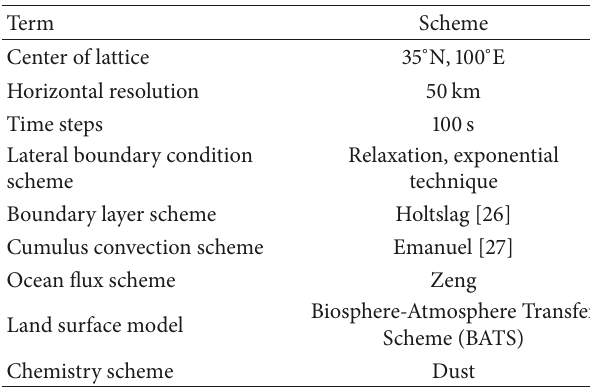
Table 4: Details of the regional climate model version 4.4 (RegCM4.4)